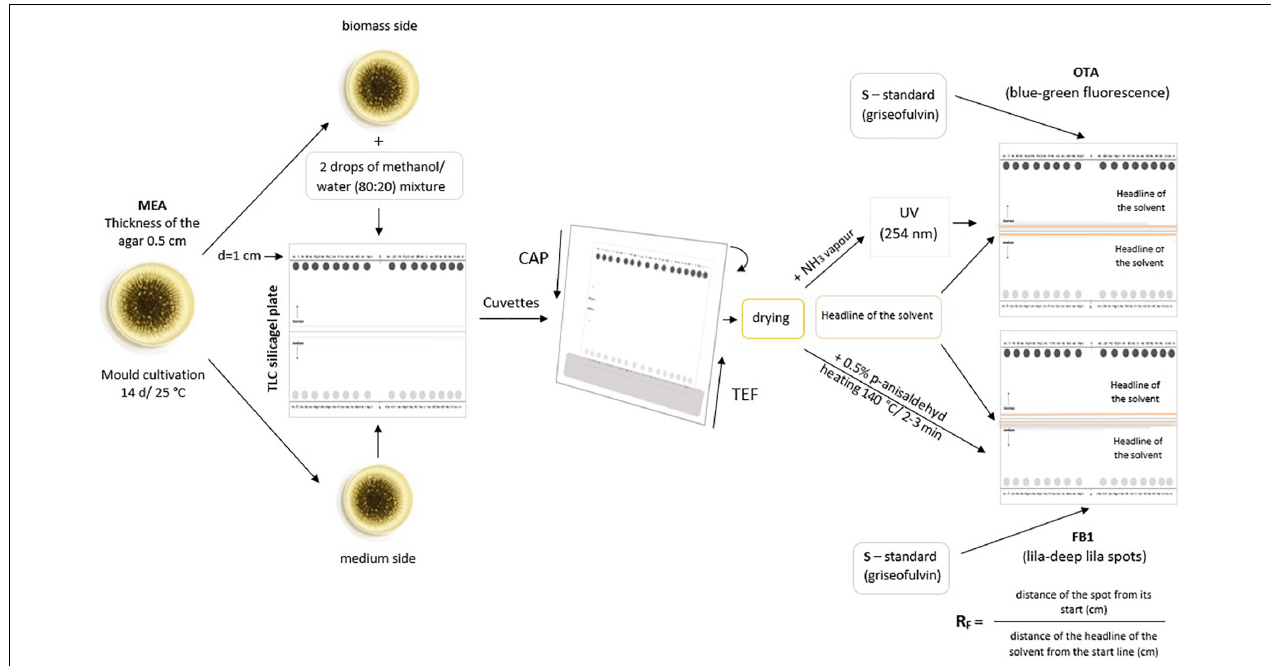
FIGURE 3 | Diagram of the TLC analysis of mycotoxins synthesised by the tested Aspergillus niger strains. MEA, malt extract agar; CAP, chloroform/acetone/isopropanol, 85:15:20; TEF, toluene/ethyl acetate/formic acid 90%, 5:4:1; OTA, ochratoxin A; FB1, fumonisin B1; Rf, retention